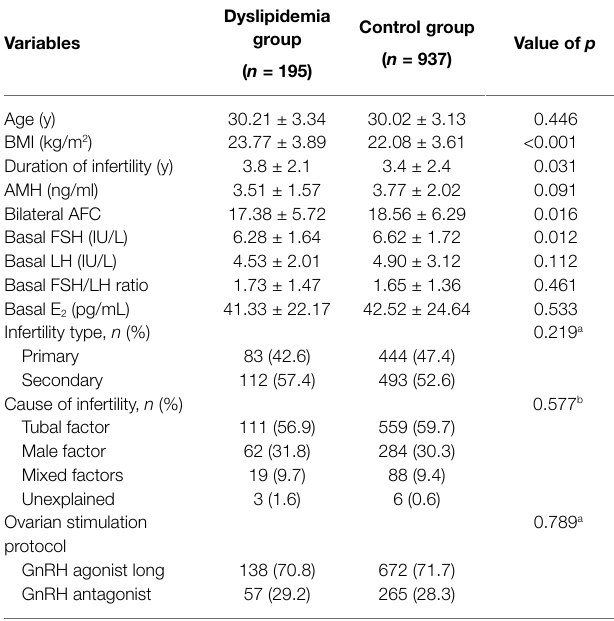
TABLE 1 | Baseline characteristics of non-PCOS patients with and without